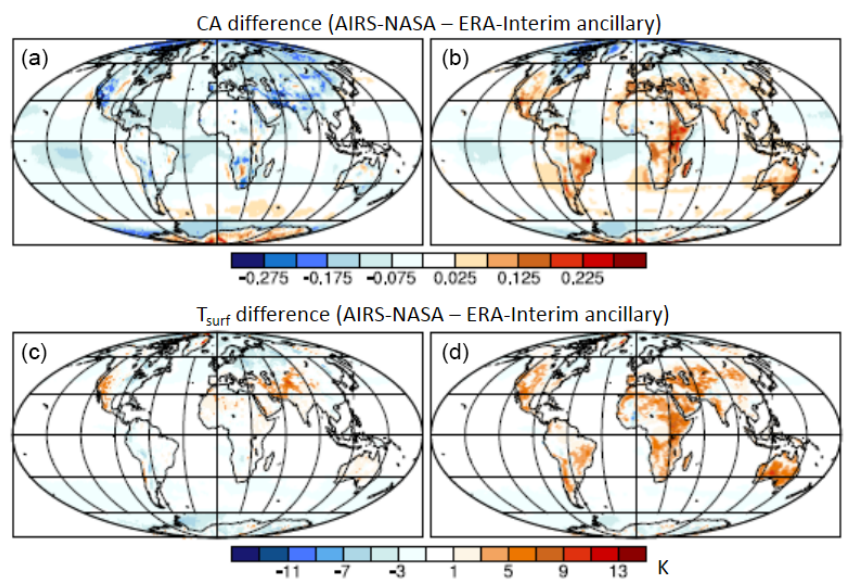
Figure 2. Geographical maps of difference in total CA (a, b) between the two AIRS-CIRS data sets, based on ancillary data from AIRS- NASA and from ERA-Interim, and in T surf (c, d) between AIRS-NASA and ERA-Interim as used in the retrieval, separately at 01:30LT (a, c) and at 13:30LT (b, d)